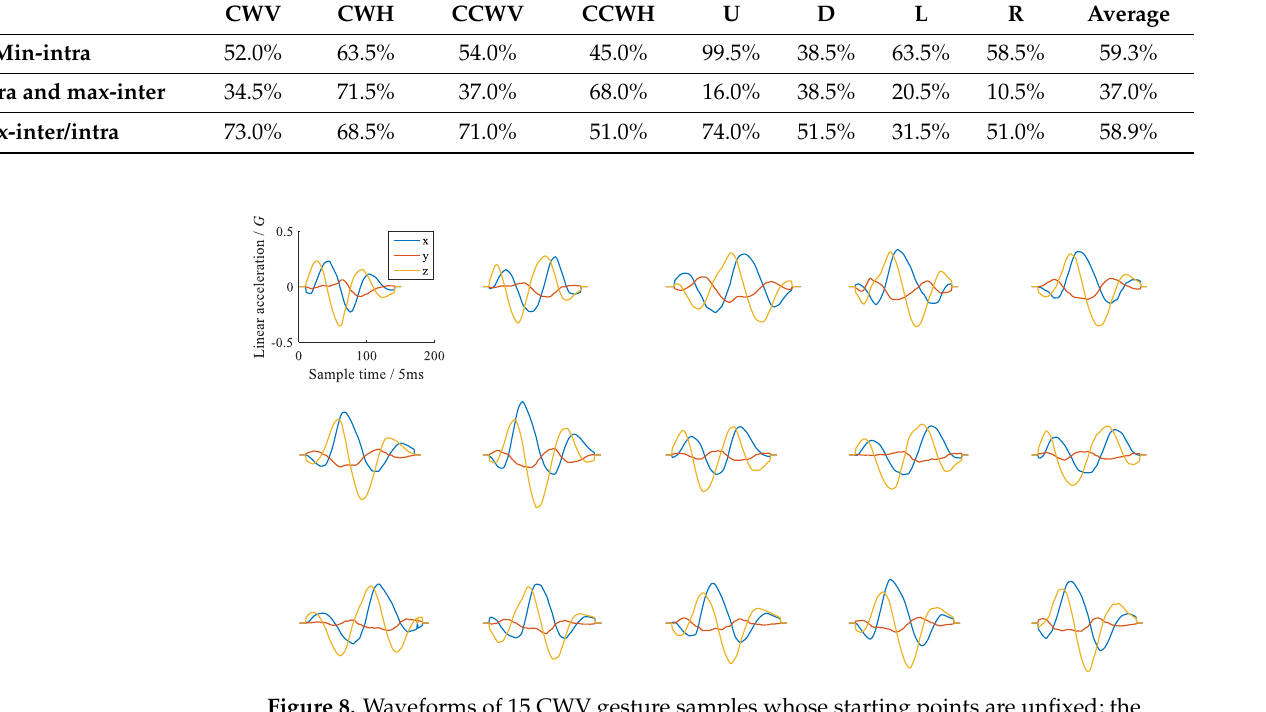
Figure 8. Waveforms of 15 CWV gesture samples whose starting points are unfixed; the waveforms waveforms evidently evidently differ.